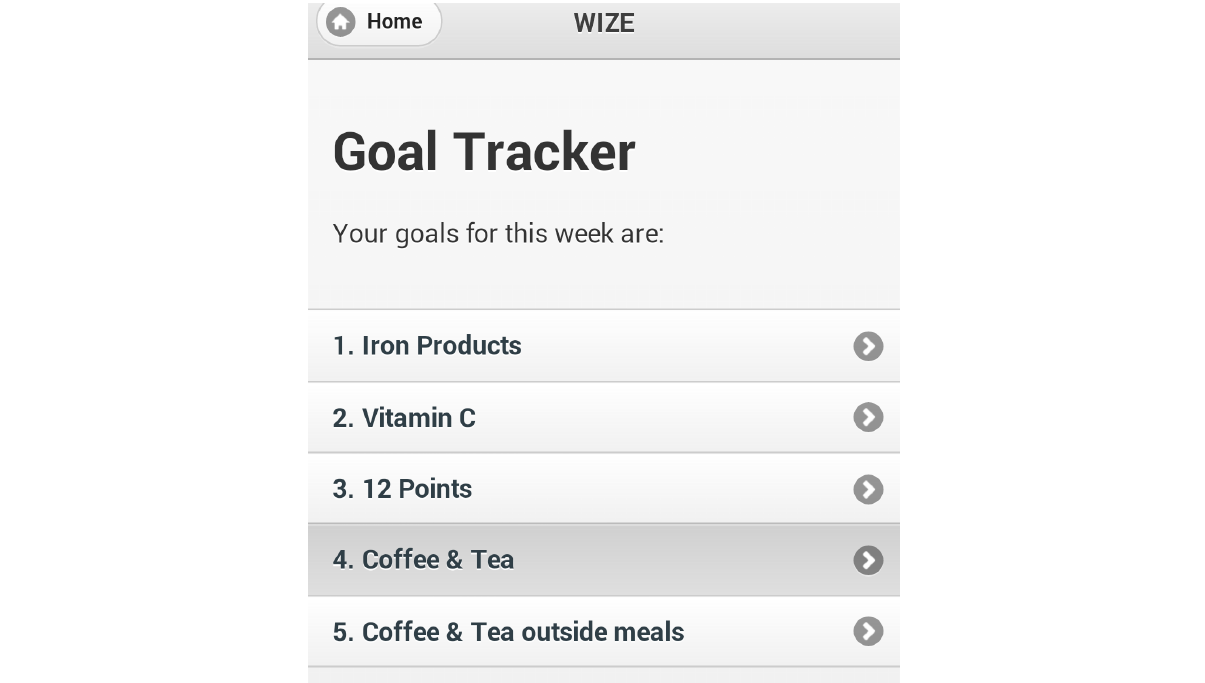
Figure 3. Screenshot of app showing goal tracker